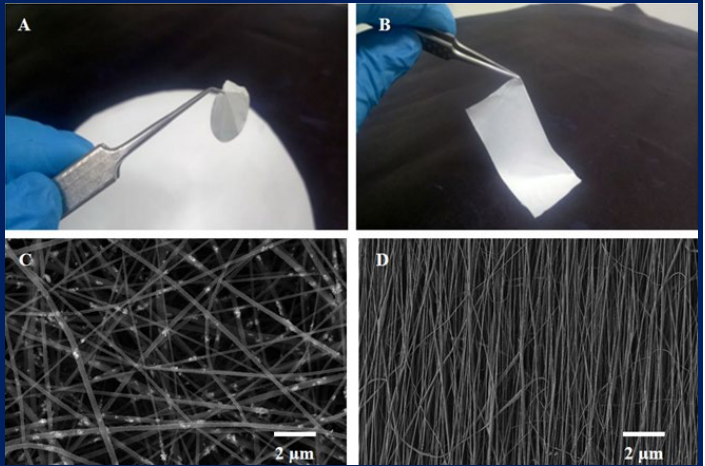
Figure 4. ( A , B ): macroscopic appearance of a 2D PCL scaffold fabricated by electrospinning technique. ( C , D ): microarchitecture of scaffolds observed under scanning electron microscopy, ( C ): randomly oriented nanofibers, and ( D ): nanofibers with parallel orientation.